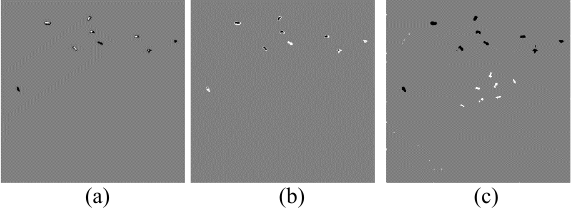
Figure 10. Change images generated by difference dual thresholds methods on Beijing. (a) KSW-GA. (b) D-OTSU. (c) RTC.